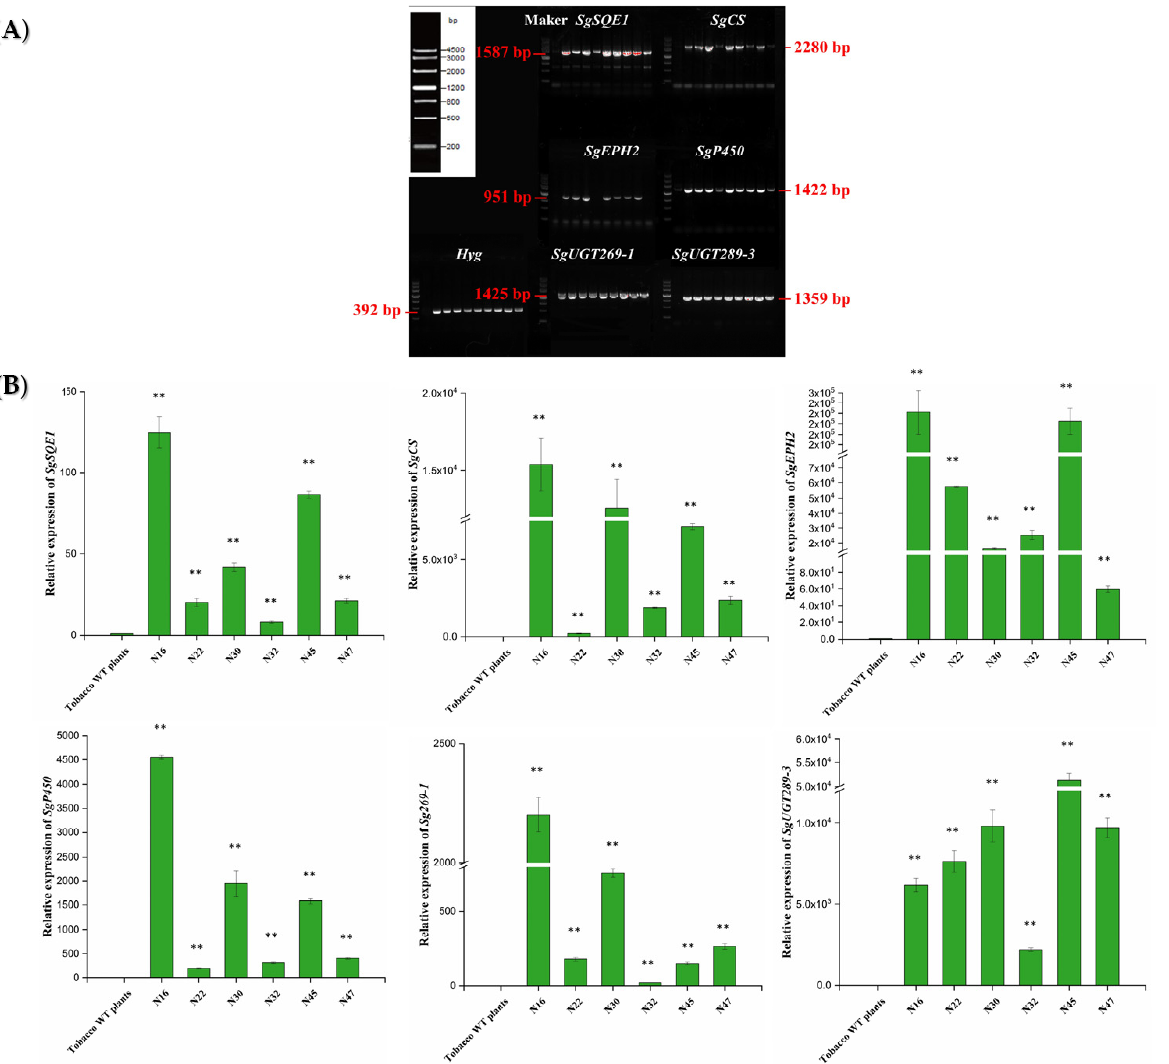
Figure 2. Molecular analysis of transgenic tobacco lines. ( A ) PCR-based analysis of the transgenic tobacco lines. The lanes from left to right represent the WT, N16, N22, N30, N31, N32, N45, N46, N47, and N48. An image of the DNA marker (4.5 kb) is shown in the upper-left corner of the figure. ( B ) Relative expression level analysis of 6 mogrosides biosynthesis genes in transgenic tobacco lines (N16, N22, N30, N32, N45, N47). The Nbactin is used as an internal control. Expression of tobacco WT plants was set to 1. The data are presented as the mean values ± SDs, n = 3 biologically independent samples, ** represents significant difference at p < 0.01 (LSD test).